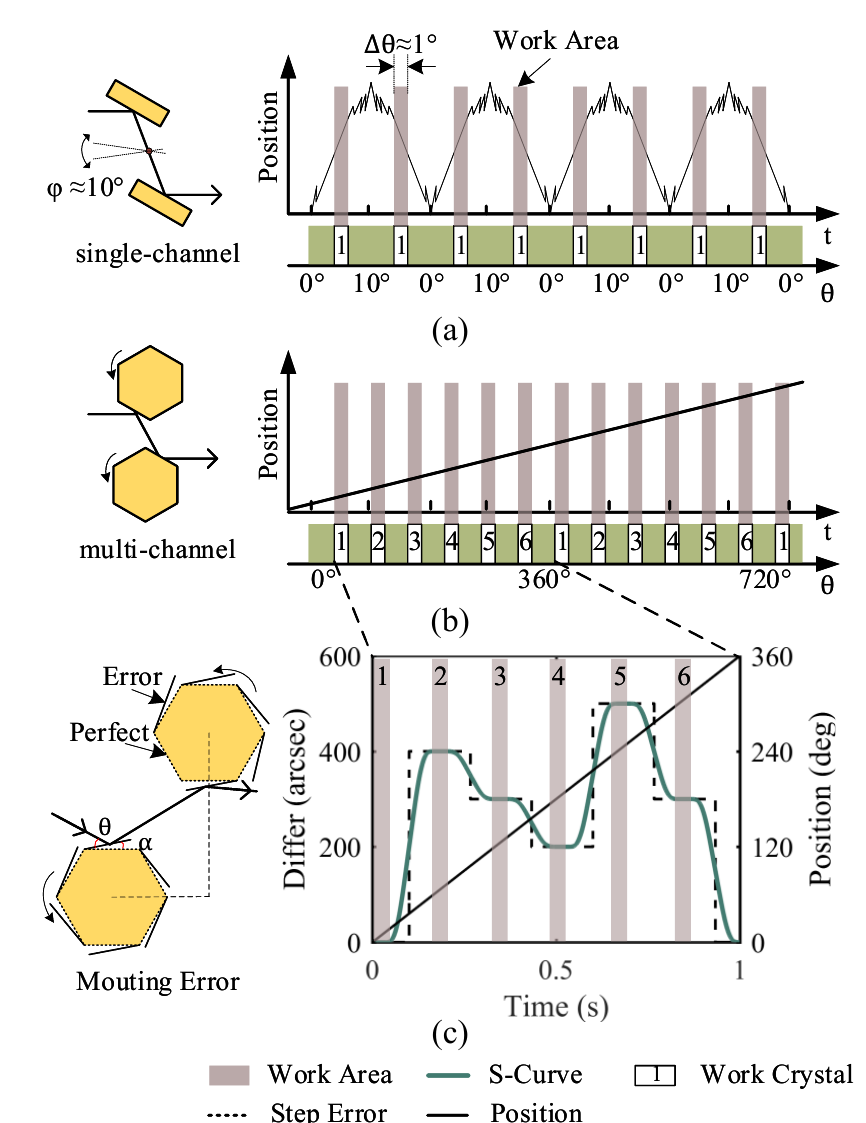
Figure 2. The comparison between the single-channel and multi-channel DCMs. The working principles of single-channel and multi-channel DCMs are separately represented by ( a , b ), the different trajectories between the master and slave motor are displayed in ( c